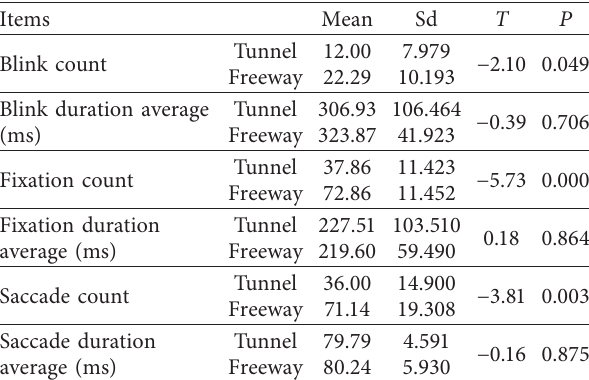
Table 3: Analysis of the driver’s eye movement data in the tunnel